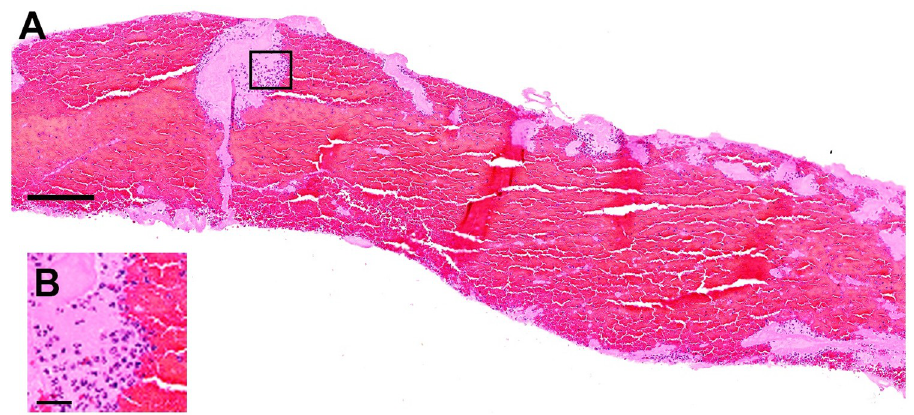
Fig 6. Representative image of fresh thrombus, classified as a red thrombus (in this case 80% of erythrocytes) in HE staining (A), red area represents erythrocytes; Inset: a higher magnification image (B) showing the interface of small area of platelet aggregates (pale pink staining) with red blood cells and granulocytes (dark purple nucleated cells). Images are from the same patient as Fig 5. Bar scale in A: 200 μ m and in B: 25 μ m.